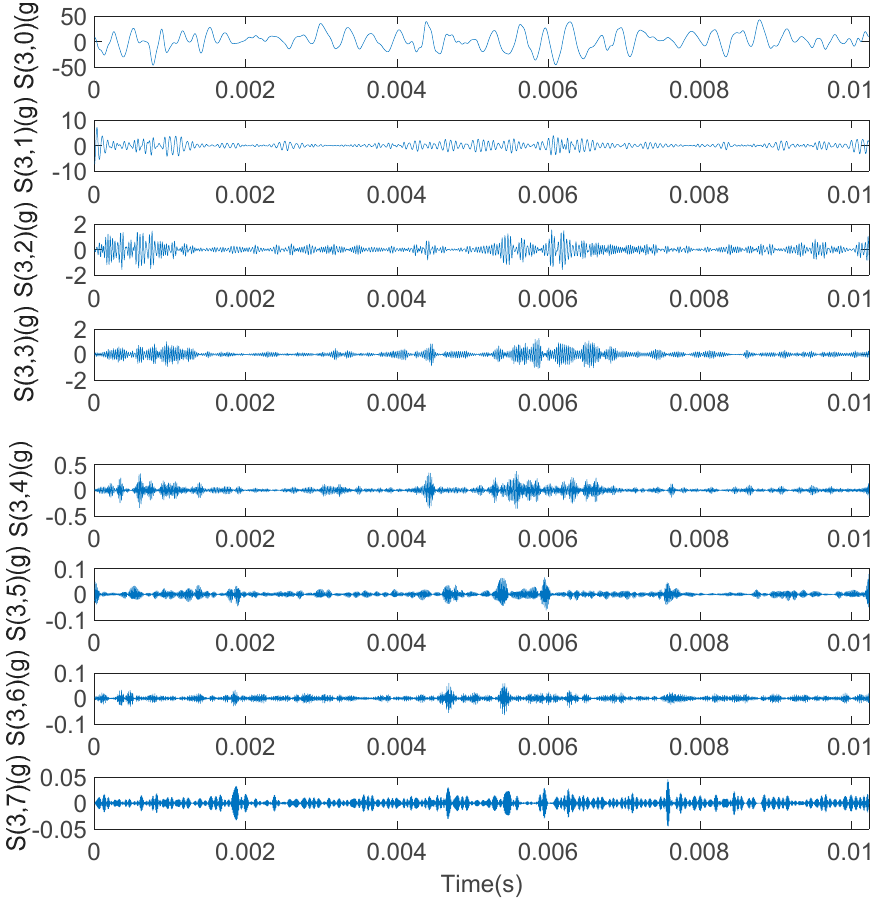
Figure 20. The reconstruction signals corresponding to eight nodes in the third layer. Calculate the energy percentage for the reconstructed signal of eight nodes in three layers, as